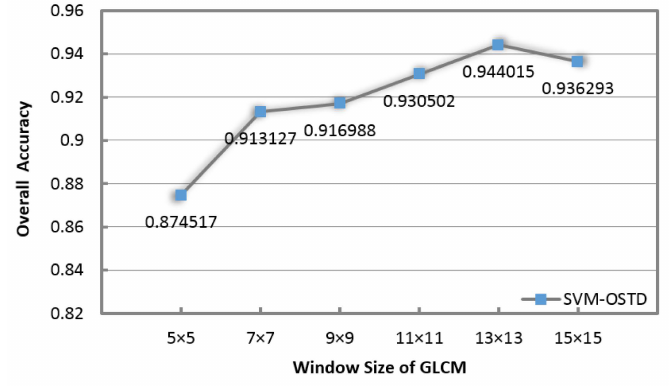
Figure 8. Sensitivity analysis of the spatial scale adopted in the textural